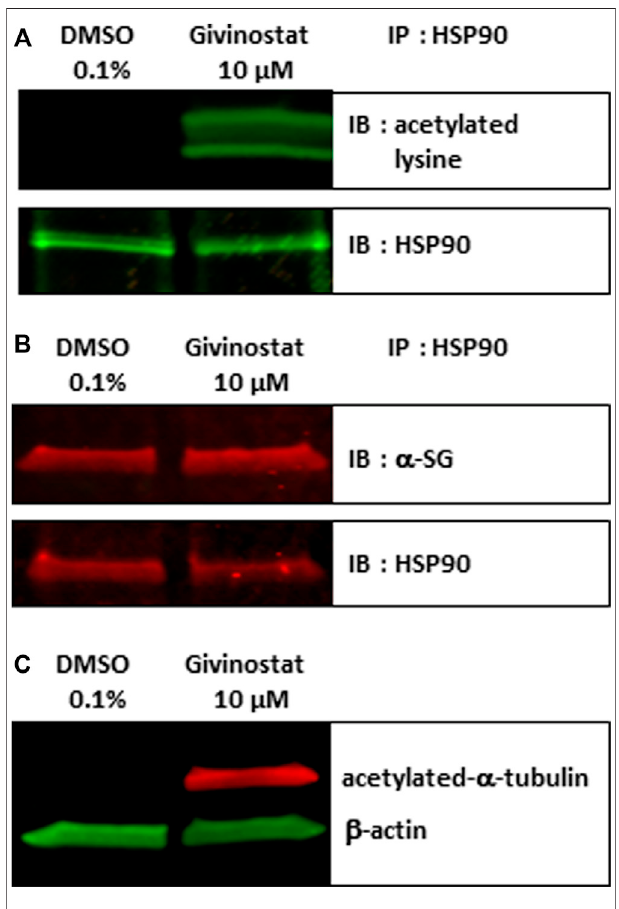
FIGURE5| Givinostatregulates HSP90and α -tubulinacetylation. (A – B) Total cell lysates of fi broblasts overexpressing R77C- α -SGmCh treated with givinostat (10 μ M) or DMSO (0.1%) for 24 h were prepared and immunoprecipitated to HSP90. Immunoblot analysis was performed with anti-acetylated-lysine (A) , with anti- α -SG (B) and anti-HSP90 antibodies. (C) Immunoblot analysis acetylated- α -tubulin expression in treated fi broblasts. β -actin was a loading